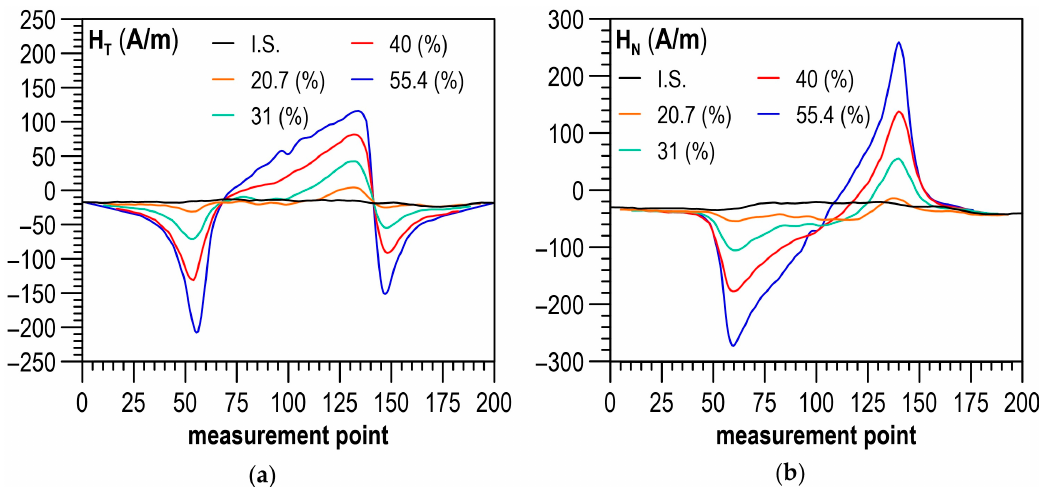
Figure 6. Distribution of the RMF components for different plastic deformation states: ( a ) tangential component H T ; ( b ) normal component H N .